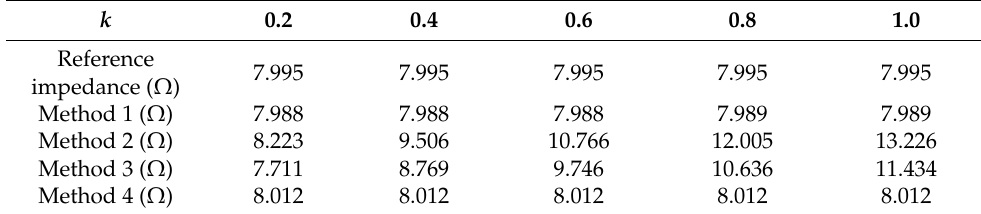
Table 2. Imaginary part average impedance.